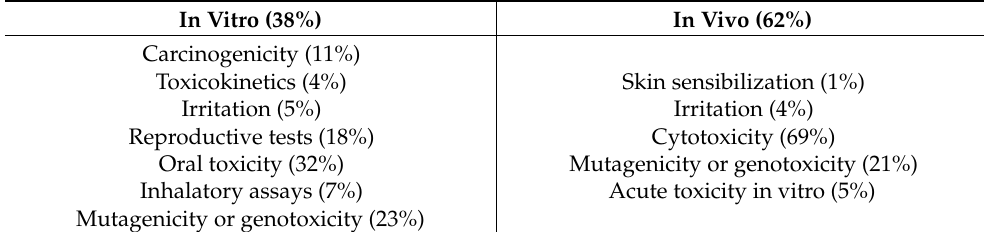
Table 3. Toxicological information found in the literature (WOS on 11 September